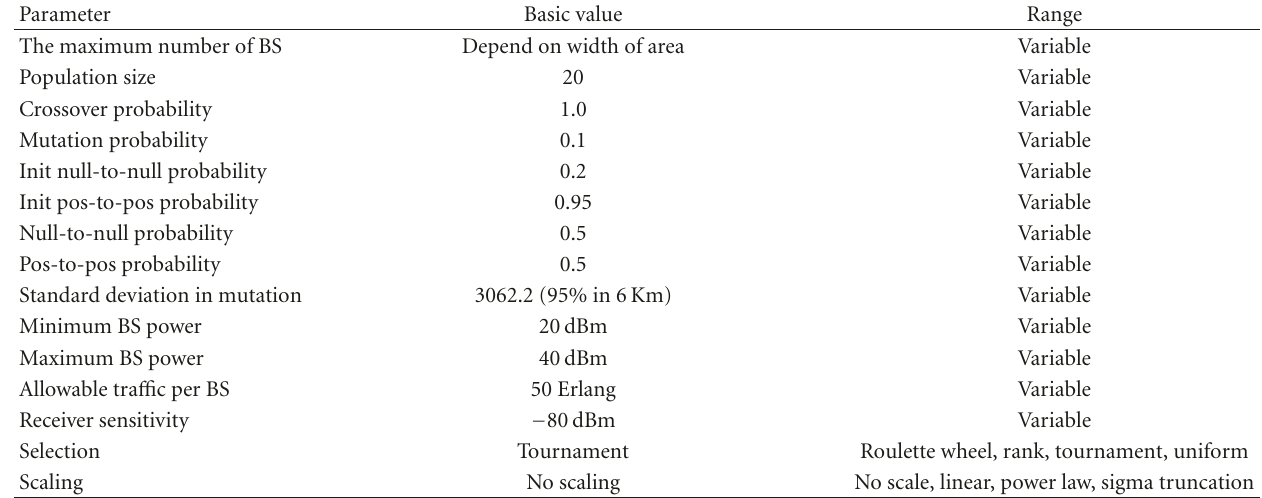
Table 2: Input parameters list.